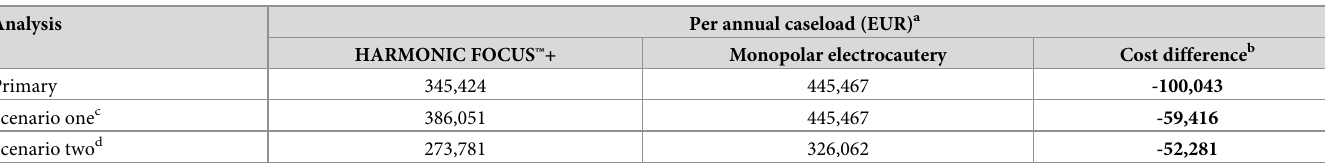
Table 3. Results of the scenario